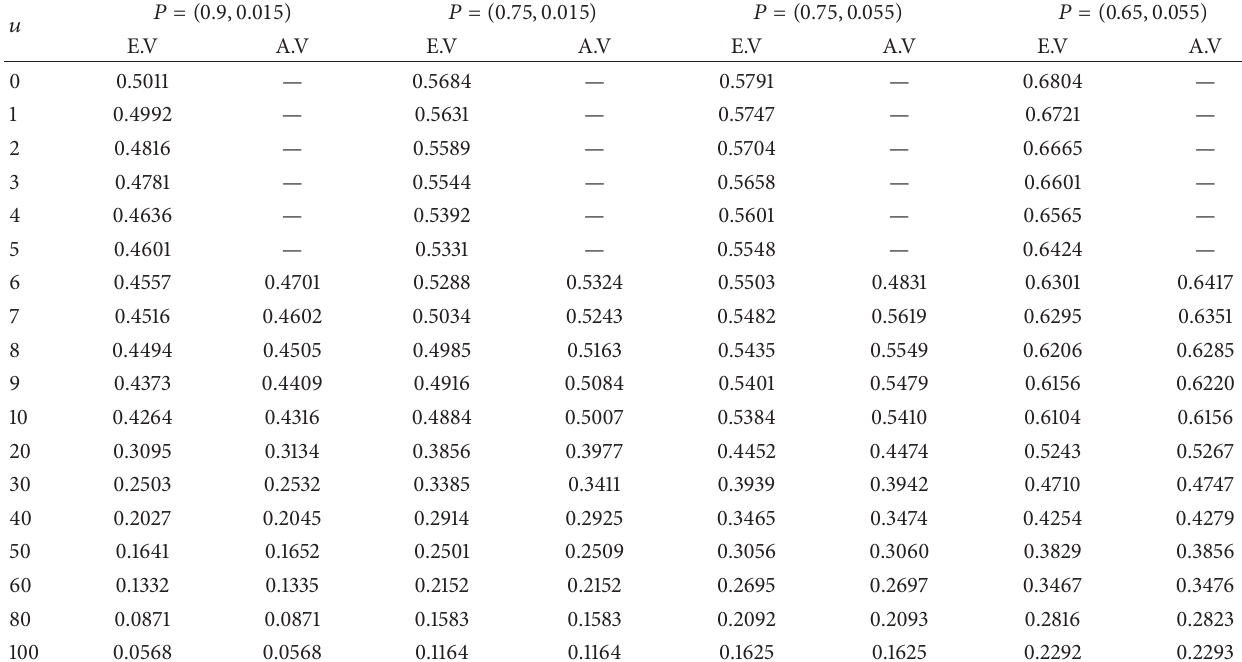
Table 2: Exact values and asymptotic values for the ruin